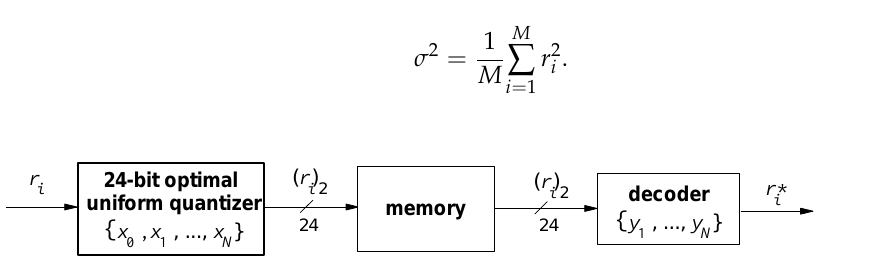
Figure 1. Process of the uniform quantization.